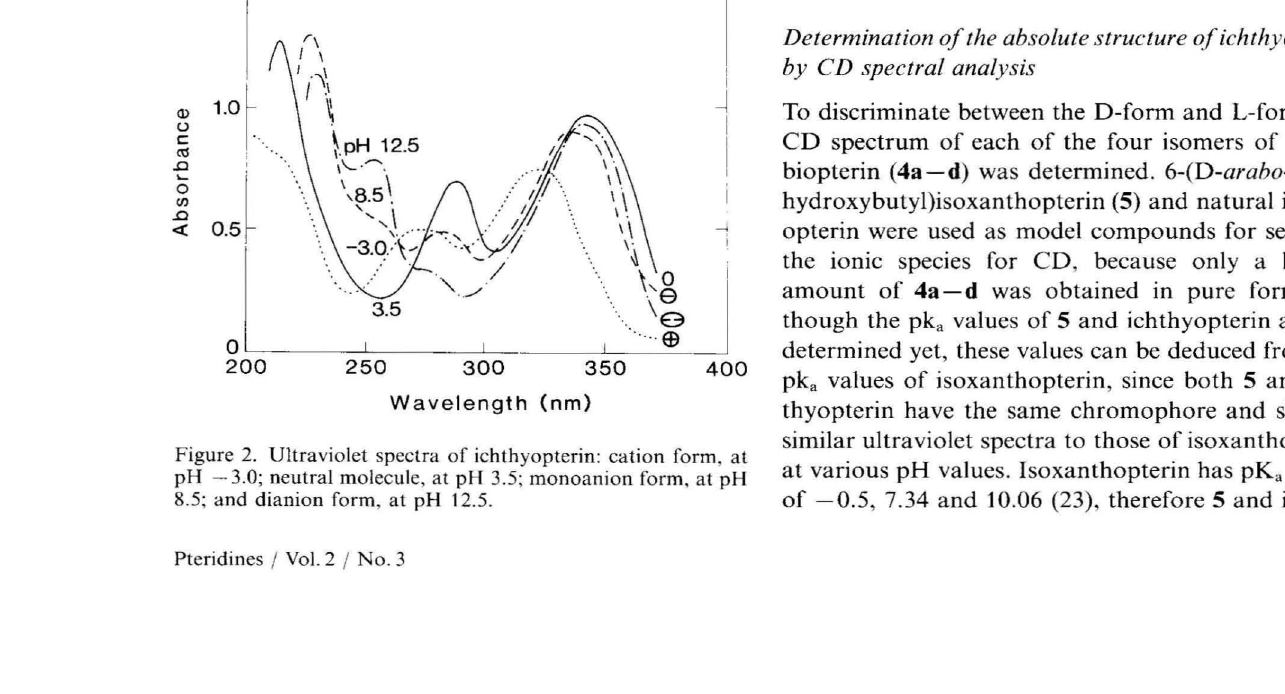
Figure 1. Fluorimetric detection of 7-oxo-biopterin produced from biopterin by the pterin 7-oxidase from the skin of carp. Analysis of pterins in the reaction mixture was performed on an Asahipak GS-320 H HPLC-column (7.6 x 250 mm) with the mobile phase consisted of 0.005% phosphoric acid in 10% aqueous methanol at a flow rate of 1.2 ml/min. Excitation at 348 nm, emission at 420 nm. About 30 mg of biopterin was incubated at 37 "C with the pterin 7-oxidasc (300 mg of protein) in 180 ml of 50 mM Tris-HCl buffer (pH 8.0) for 24 h.